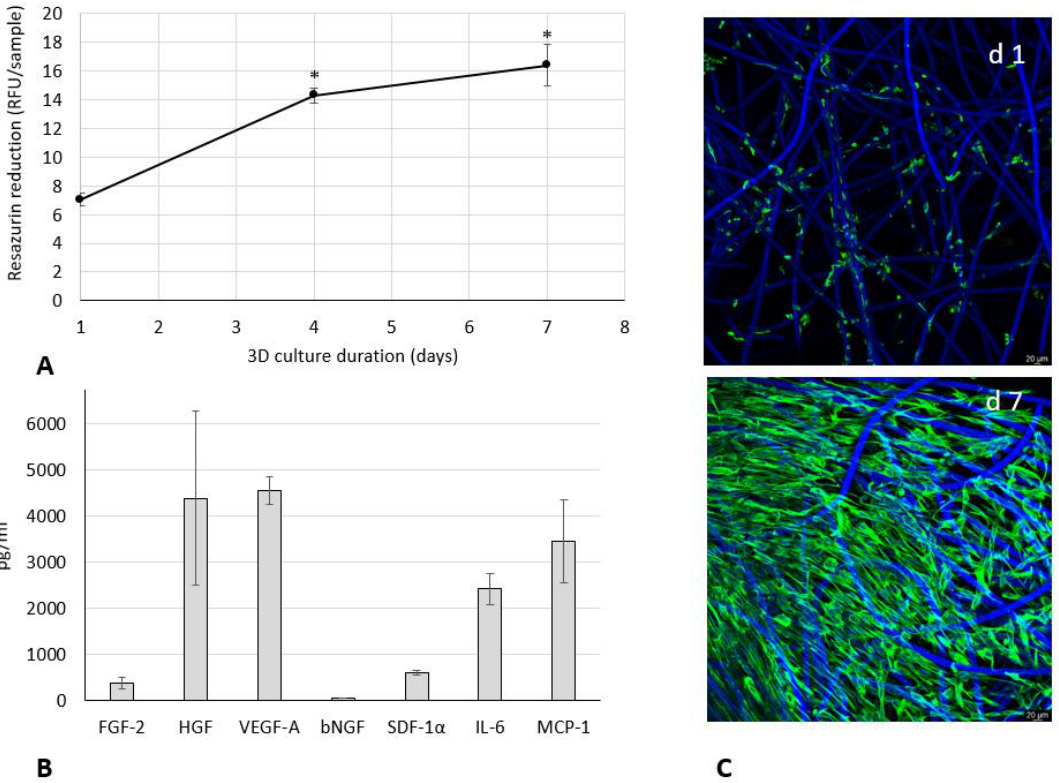
Figure 1. Growth ( A ), paracrine secretion profile ( B ), and morphology ( C ) of WJ-MSCs during culture in 3D HyaloFast ® scaffolds ( n = 8). ( A )—resazurin assay; ( B )—multiplex ProcartaPlex ® Immunoassay of conditioned medium samples (Mean ± SD). ( C )—Vimentin (green)/bisBenzimide (blue) staining of cells at d 1 (upper) and d 7 (lower) of culture in standard conditions; *—the data are significantly ( p < 0.05) different compared to d 1 of culture.